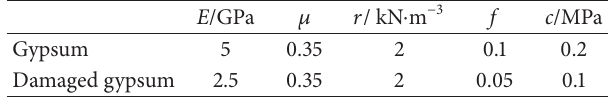
Table 1: Materials